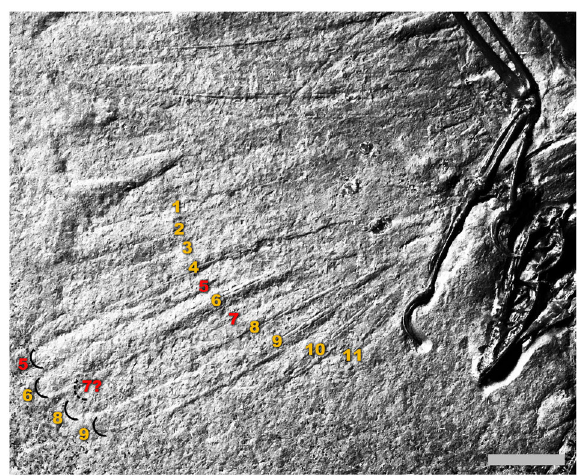
Fig. 4 Right wing of WDC-CSG-100 under white raking light showing numbered primary feathers. Arrow delimiting the full length of a molted feather in WDC-CSG-100. This fi gure shows that primaries #5 and #7 were nearly full length. Corni fi ed feather sheaths on primaries #5 and #7 are visible under LSF in Fig. 3a. The numbering on the feathers follows Mayr et al. 13 . The image is in grayscale and under white raking light to make the feathers easier to see. Scale bar is 2